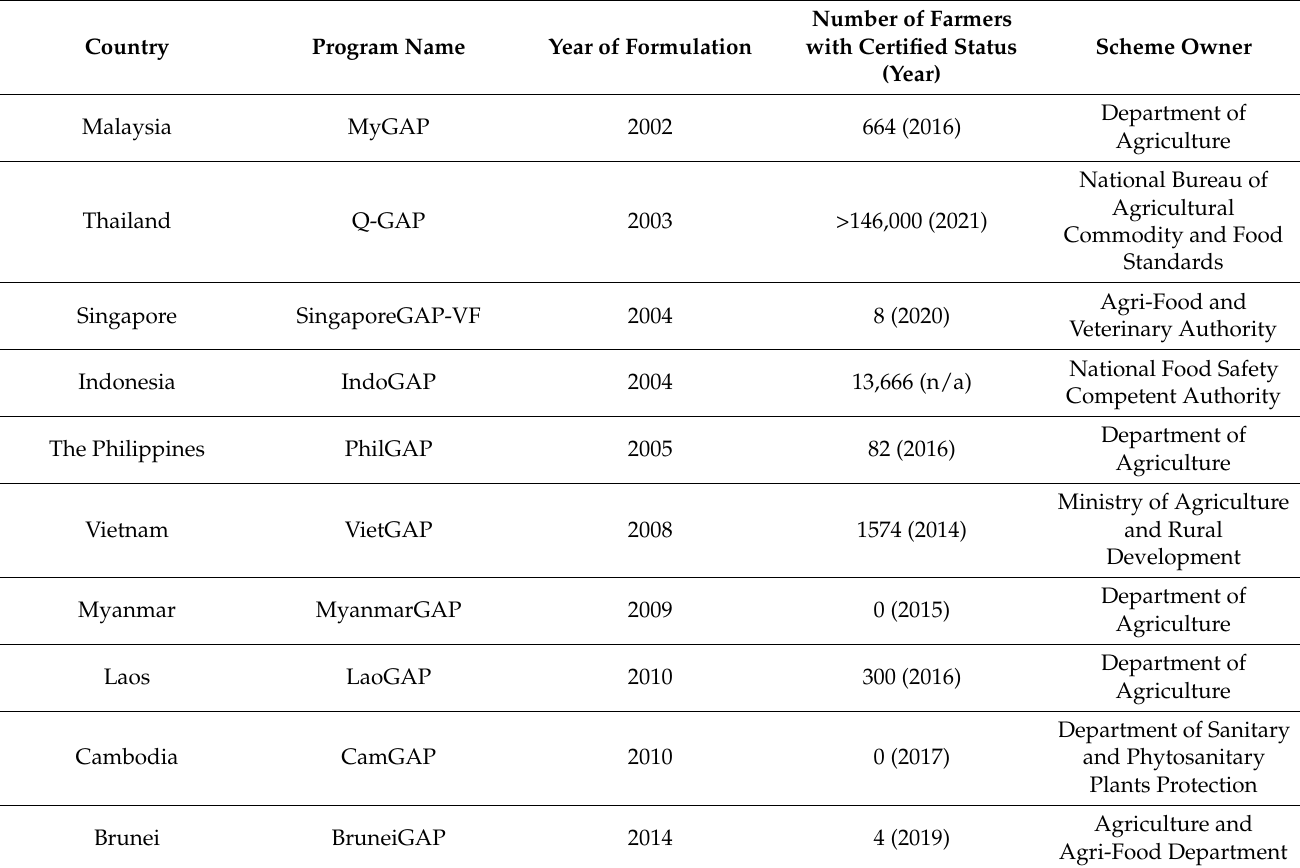
Table A1. Adoption of national public GAP standards by farmers in ASEAN